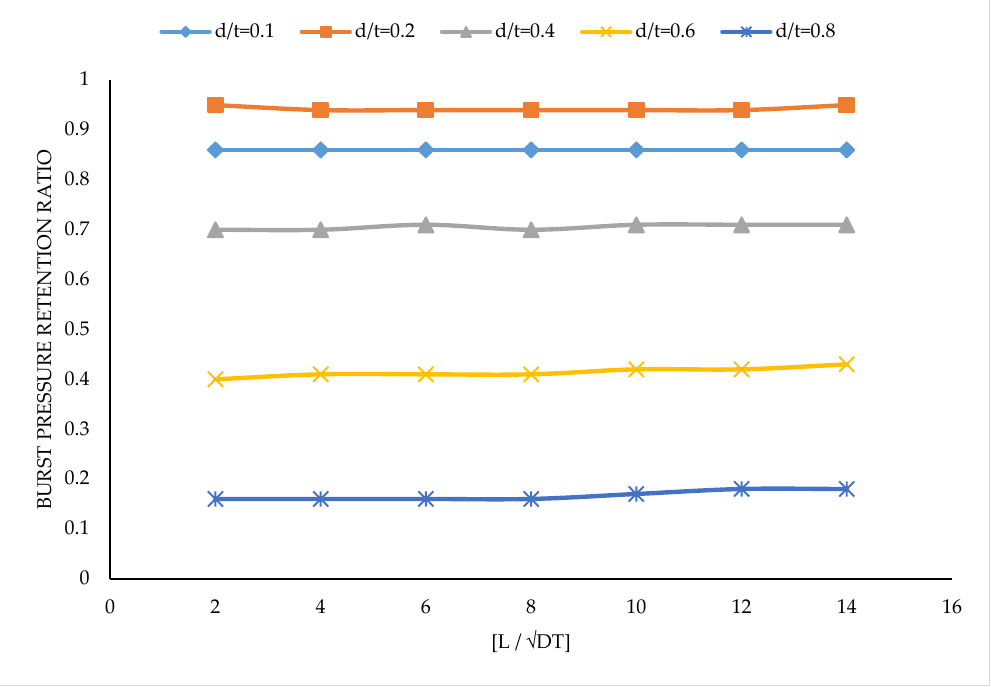
√ Dt for 534.4 mm diameter and 8.71 mm